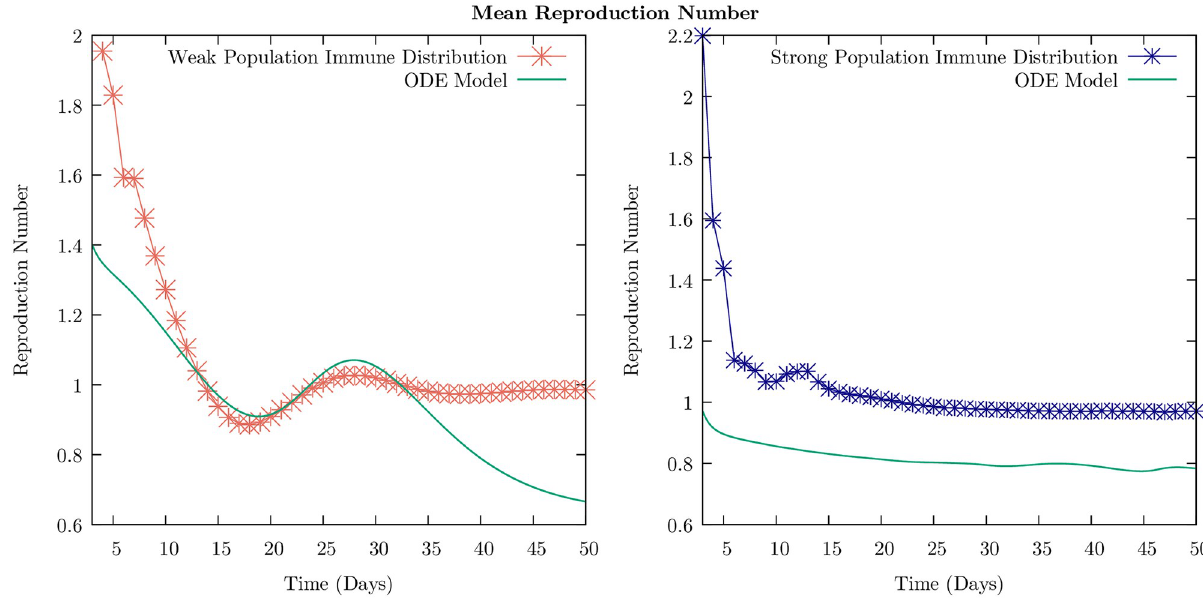
Fig 8. Mean reproduction number as a function of time for the weak and strong immune population distributions described in Figs 3 and 4, respectively. Means were calculated over 10,000 sample simulations, and are plotted as points with lines interpolated between them alongside the reproduction number defined for the two-cohort ODE SEIR model in Eq 4. Note that the ABM simulations were for a four-cohort structure, accounting for some differences between the two traces. We see that the effect of a global increase in the immune profile of the population is a suppression of (a) the initial spread of the disease, seen through a reduction in the reproduction number, and (b) of recurrent infection waves, seen through the elimination of the second interval of time where R > 1.